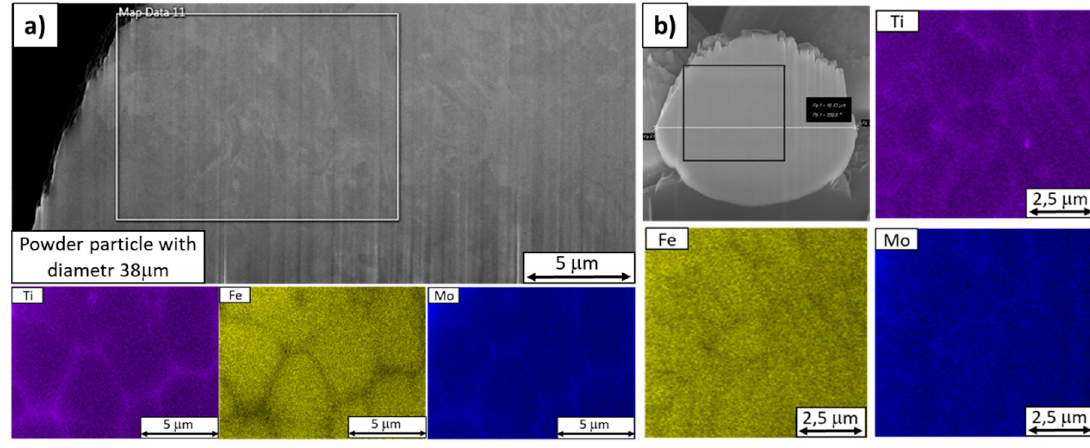
Figure 6. EDS maps of virgin powder particles. ( a ) A larger particle with a diameter of 38 μ m with a partially etched microstructure, ( b ) a smaller particle, 16.5 μ m in diameter.